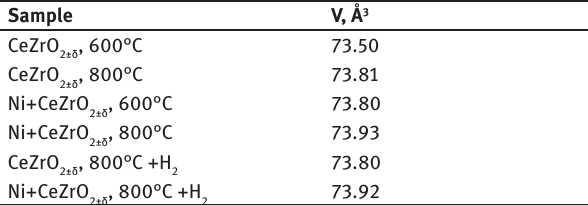
Zr O 0.5 0.5 2±δ